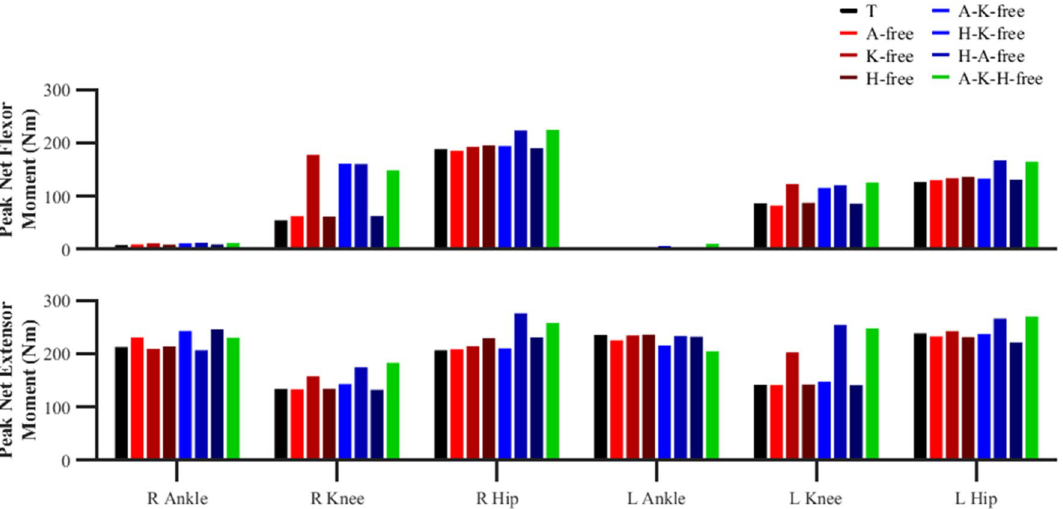
Figure 9. Right (R) and left (L) peak ankle dorsiflexor and plantarflexor net moments, and peak knee and hip net flexor and extensor moments during the right and left stance phases for the data-tracking (T) and predictive simulations (A-free, K-free, H-free, A-K-free, H-K-free, H-A-free,